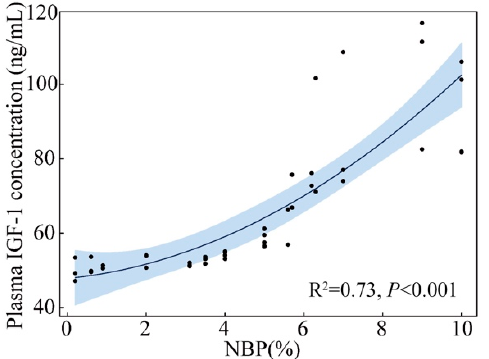
Figure 3. The relationship between nymph biomass (NBP) and plasma insulin-like growth factor-1 (IGF-1) concentrations of Asian short-toed lark ( Alaudala cheleensis ) nestlings ( n = 45). NBP is the proportion of the daily grasshopper nymph biomass relative to the total biomass measured on all survey days. The blue area is the confidence interval.